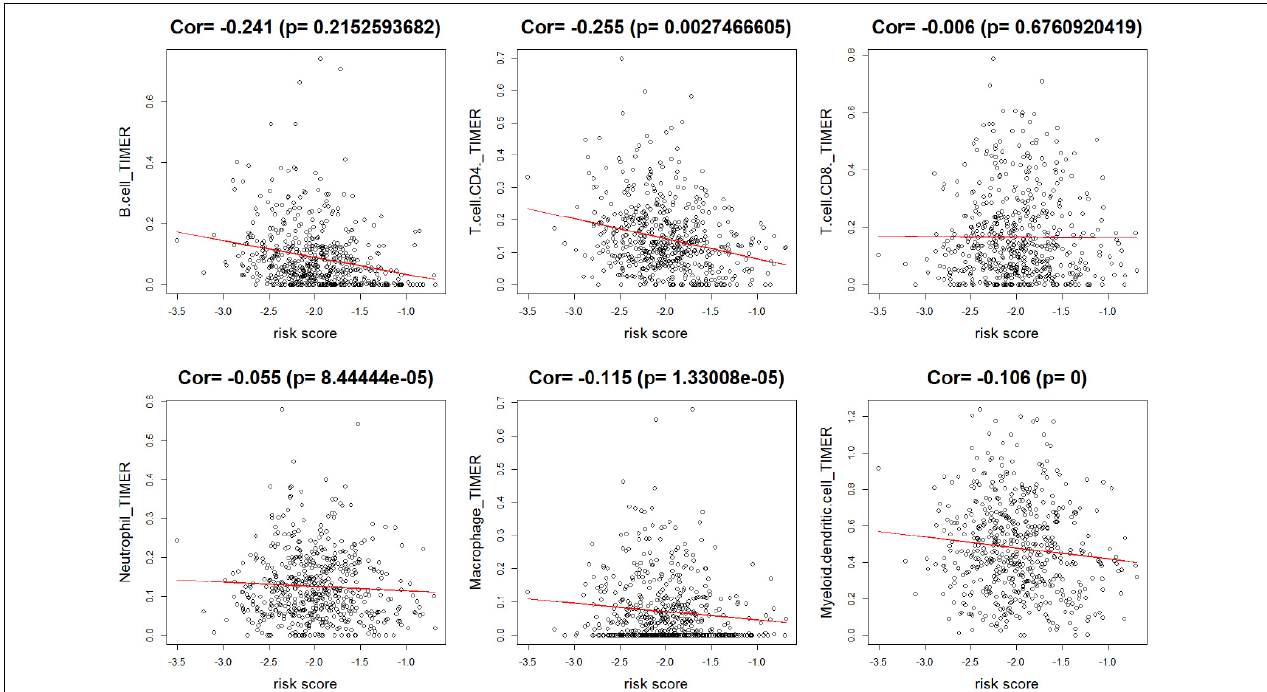
FIGURE 7 | Correlation between risk score and immune cell subtype infiltration. The correlation values of B cells, CD4 + T cells, CD8 + T cells, neutrophils, macrophages, and myeloid dendritic cells were − 0.241, − 0.255, − 0.006, − 0.055, − 0.115, and − 0.106, respectively. Only B cells, CD4 + T cells, macrophages, and myeloid dendritic cells were significantly correlated with risk score ( p <